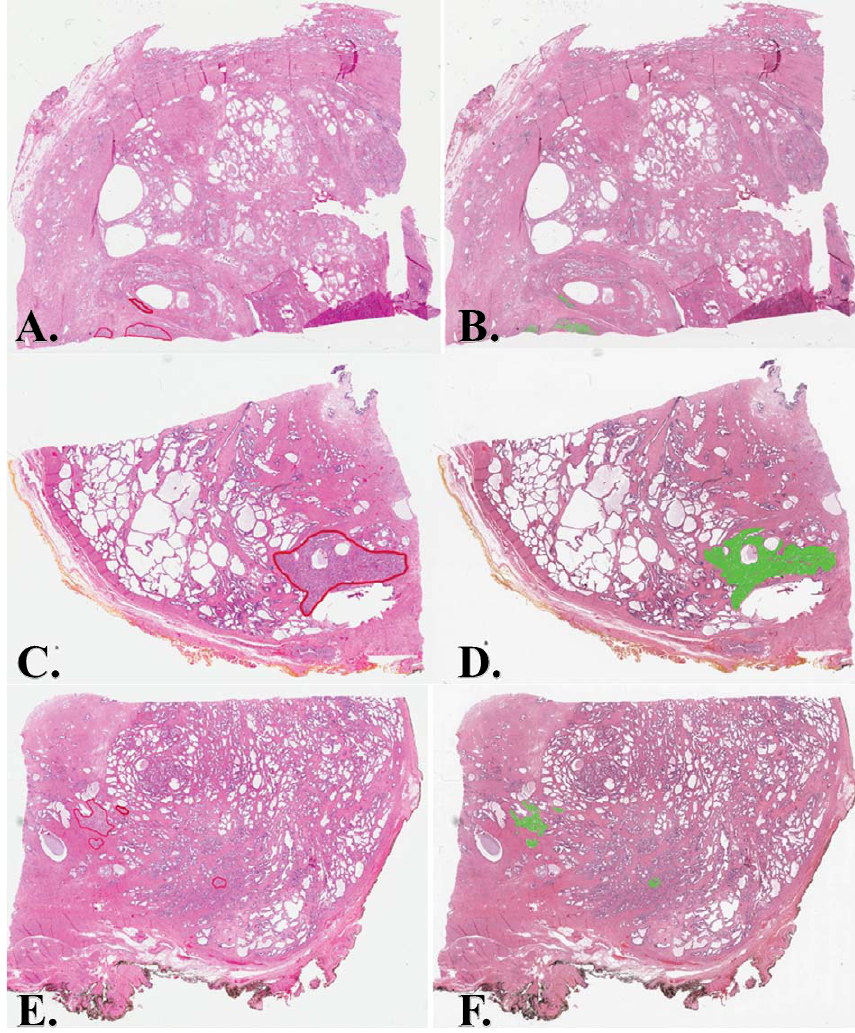
Fig. 1. Ground truth maps of the H&E stained prostate tissue section. Digital slides from the Monaco et al. [12] data set were used for this study. 3 H&E stained prostatic tissue sections had been scanned into digital slides. The cancerous areas were annotated (circled) by pathologists in red (A, C, E). Additionally, the malignant prostatic epithelium was annotated (painted) by a pathologist in green (B, D, F). (Colours are visible in the online version of the article;